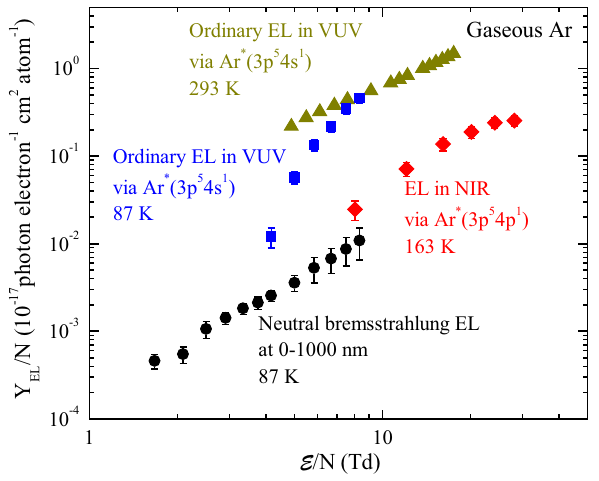
Fig. 2 SummaryofexperimentaldataonthereducedELyieldinargon for all known electroluminescence (EL) mechanisms: for NBrS EL at wavelengths of 0–1000 nm, measured in [16] at 87 K; for ordinary EL in the VUV, going via Ar ∗ (3p 5 4s 1 ), measured in [16] at 87 K and in [25] at 293 K; for EL in the NIR going via Ar ∗ (3p 5 4p 1 ), measured in [14] at 163